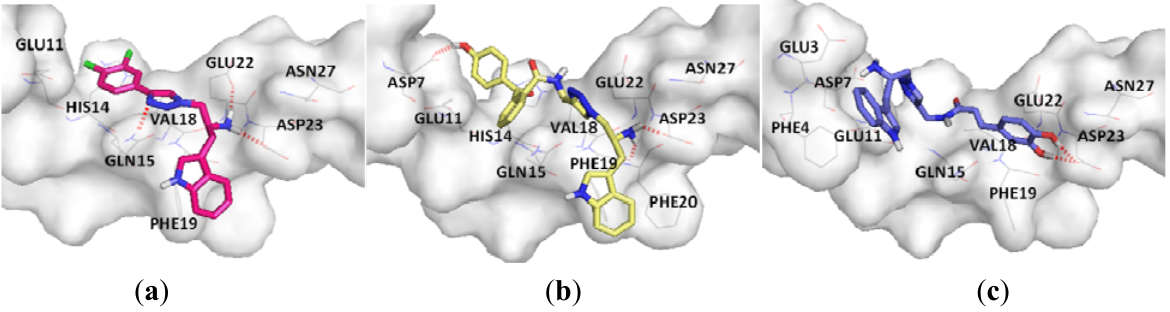
Figure 4. The binding mode of compounds with amyloid- β (1-42); ( a ) 12c (pink); ( b ) 12d (yellow); ( c ) 12h (blue).